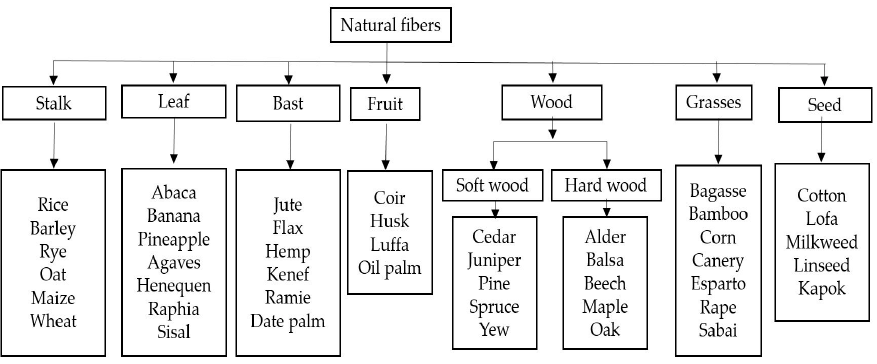
Figure 4. Classification of natural fibers [22–24].